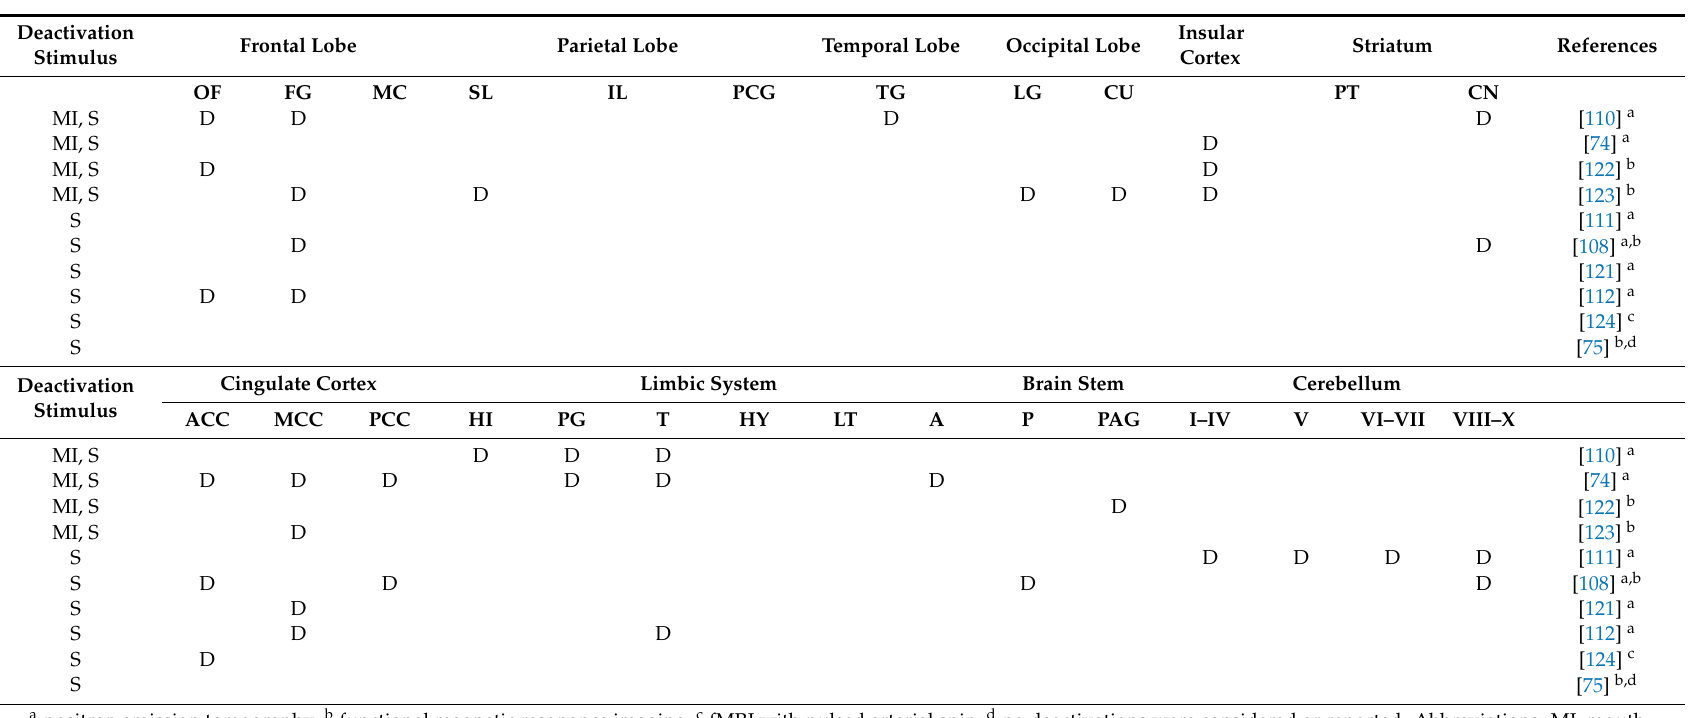
Table 3. Deactivation (D) of human brain regions in response to mouth irrigation and drinking to